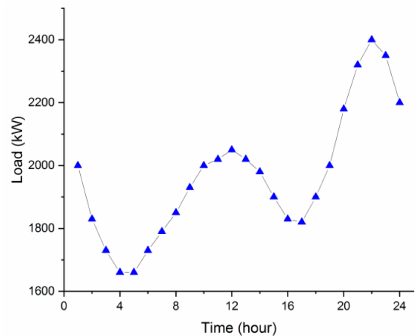
Figure 5. Load curve.